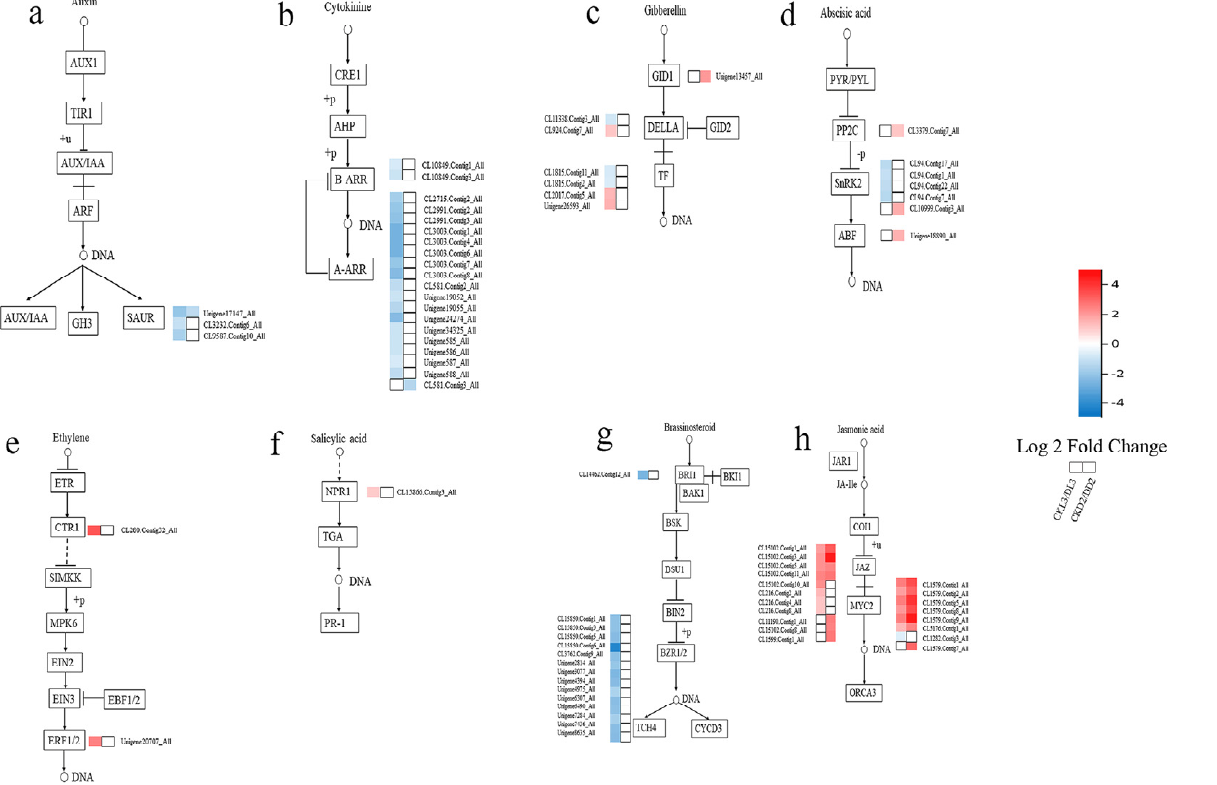
Figure 5. Drought-stress induced changes in phytohormone signaling pathway gene expression profiles in two comparisons: ( a ) auxin signal; ( b ) cytokinin signal; ( c ) gibberellin signal; ( d ) abscisic acid signal; ( e ) ethylene signal; ( f ) salicylic acid; ( g ) brassinosteroid signal, and ( h ) jasmonic acid signal.